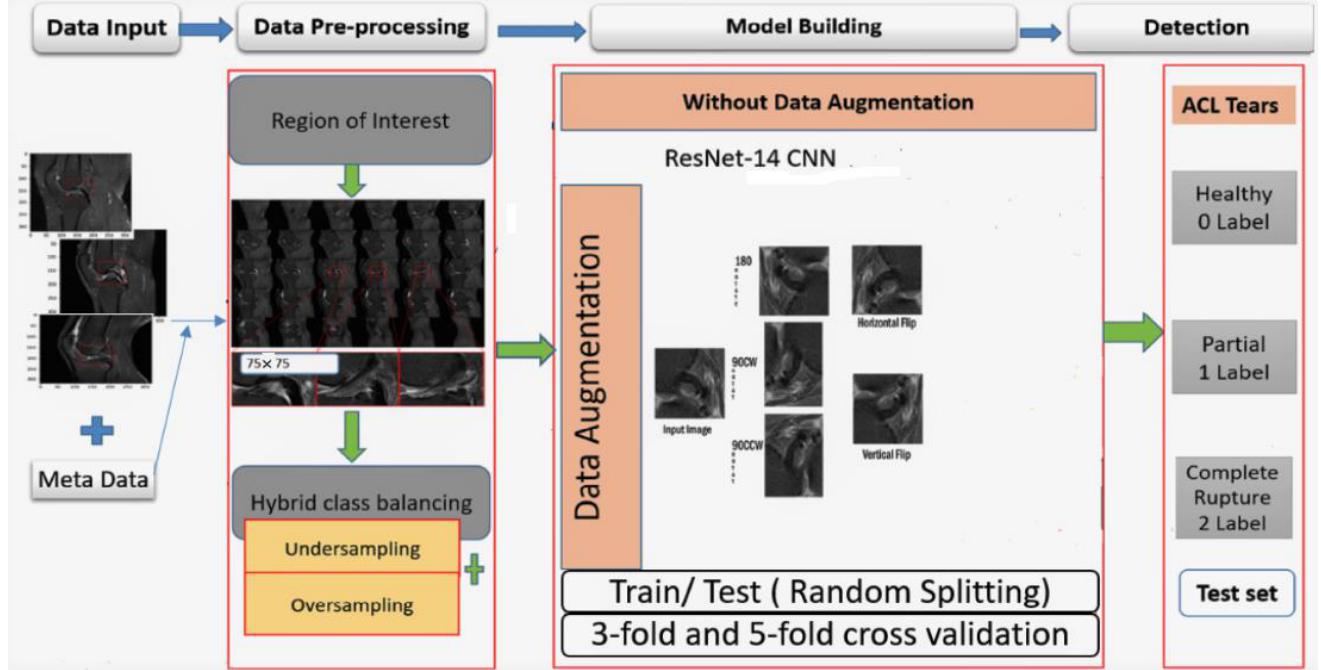
Figure 6. A block diagram of the proposed methodology.